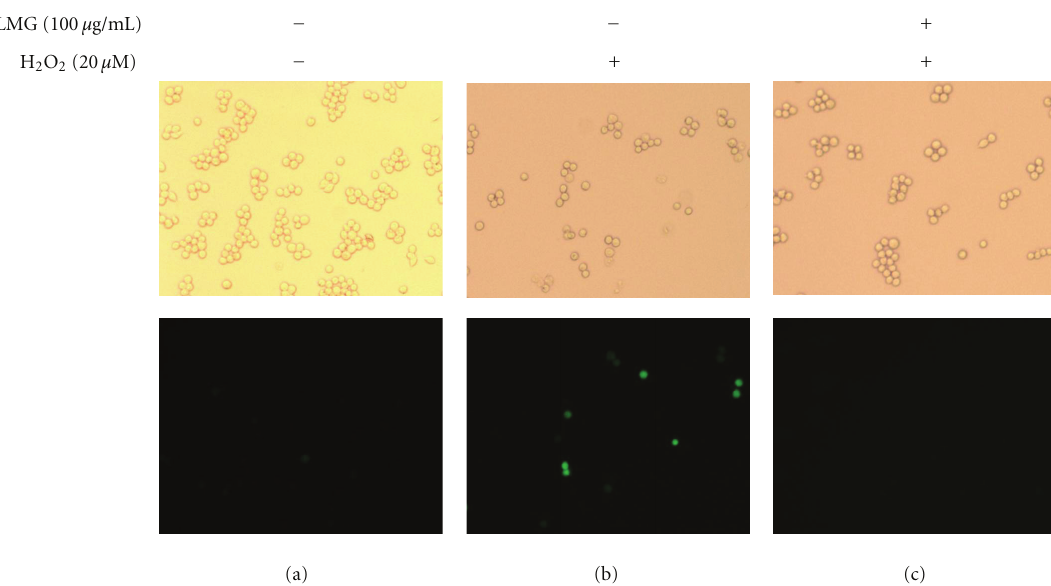
Figure 6: LMG reduced H 2 O 2 -induced intracellular ROS levels. RAW264.7 cells were treated with H 2 O 2 (20 μ M) and LMG (100 μ g/mL) for 30min, and intracellular ROS levels were measured using DCFDA fluorescent staining and fluorescence microscopy. Left panels, untreated control; middle panels, H 2 O 2 added alone; right panels, co-treatment with H 2 O 2 and LMG. Images in the upper panels were captured using bright-field microscopy (original magnification 200x), and those in the lower panels were captured using fluorescence microscopy.